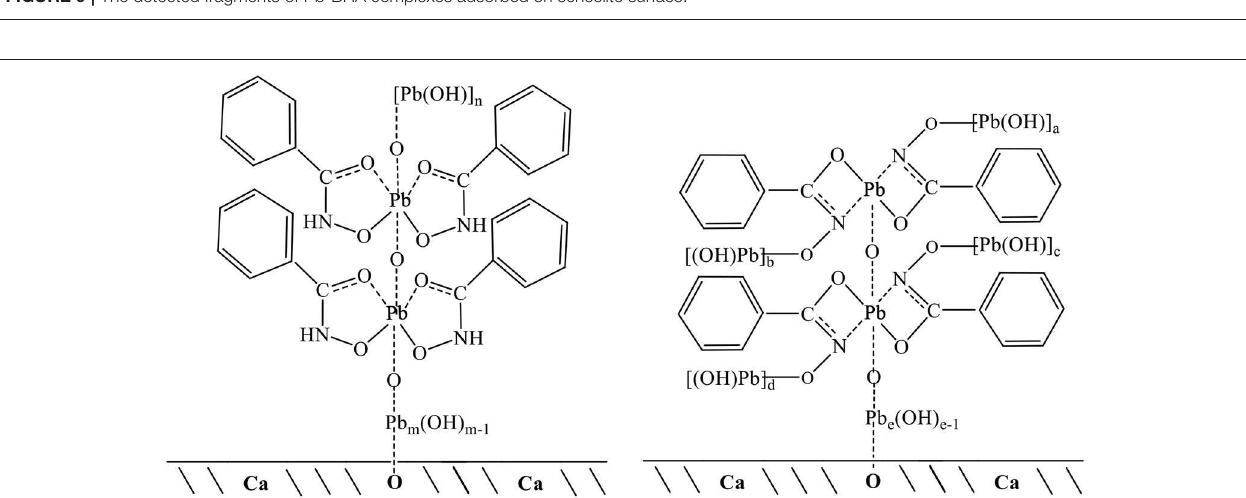
FIGURE 9 | The detected fragments of Pb-BHA complexes adsorbed on scheelite surface.